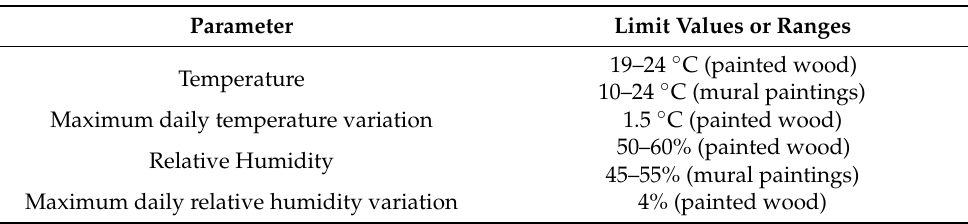
Table 2. The recommended microclimatic conditions in museum environments according to the UNI 10829:1999 technical standard.